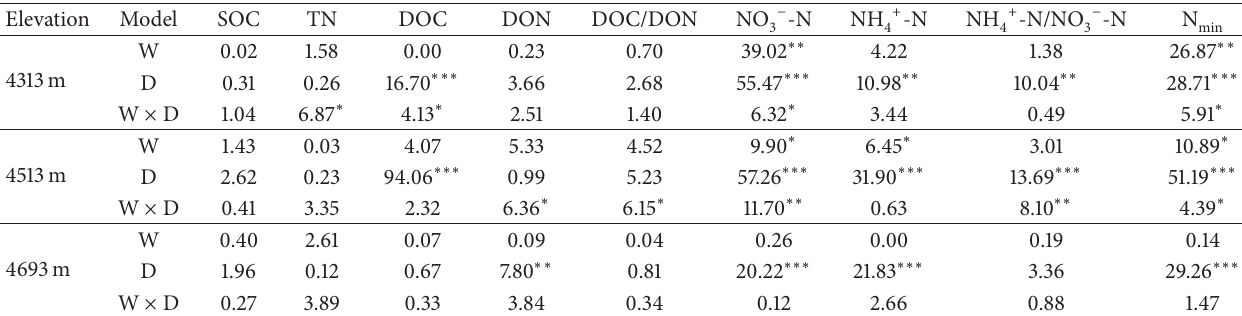
Table 1: Repeated-measures ANOVA ( 𝐹 values) for the main and interactive effects of experimental warming (W) and sampling date (D) on soil organic C (SOC), total N (TN), dissolved organic C (DOC), N (DON), ammonium N (NH Plateau at three elevations ( 𝑛 = 4